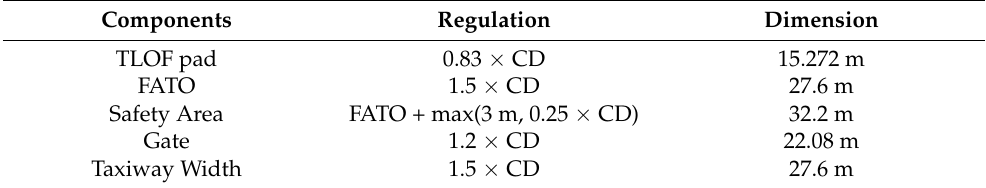
Table 2. Regulation and dimensions of primary vertiport components that comply with new EASA regulations.